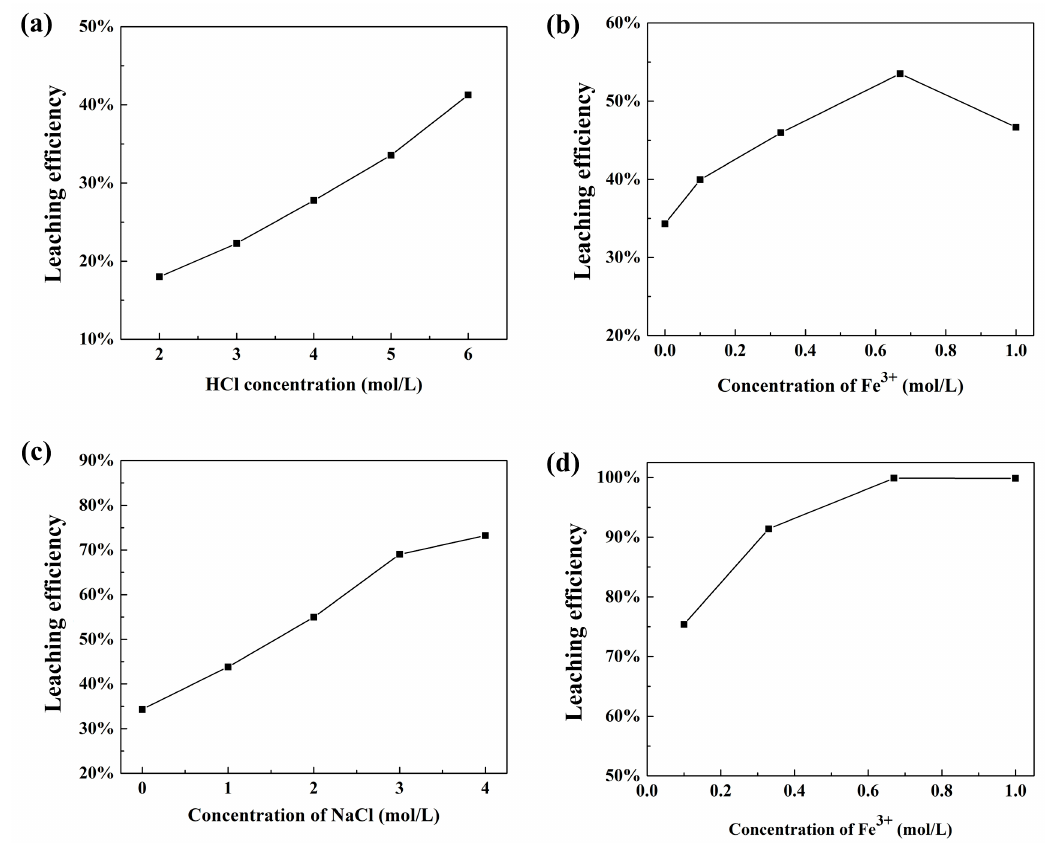
Figure 5. E ff ects on Pd leaching e ffi ciency of ( a ) concentration of HCl, ( b ) concentration of Fe 3 + , Figure 5. Effects on Pd leaching efficiency of ( a ) concentration of HCl, ( b ) concentration of Fe 3+ , ( c ) ( c ) concentration of NaCl, and ( d ) concentration of Fe 3 + with 4.0 mol / L concentration of NaCl ,and ( d ) concentration of Fe 3+ with 4.0 mol/L NaCl.